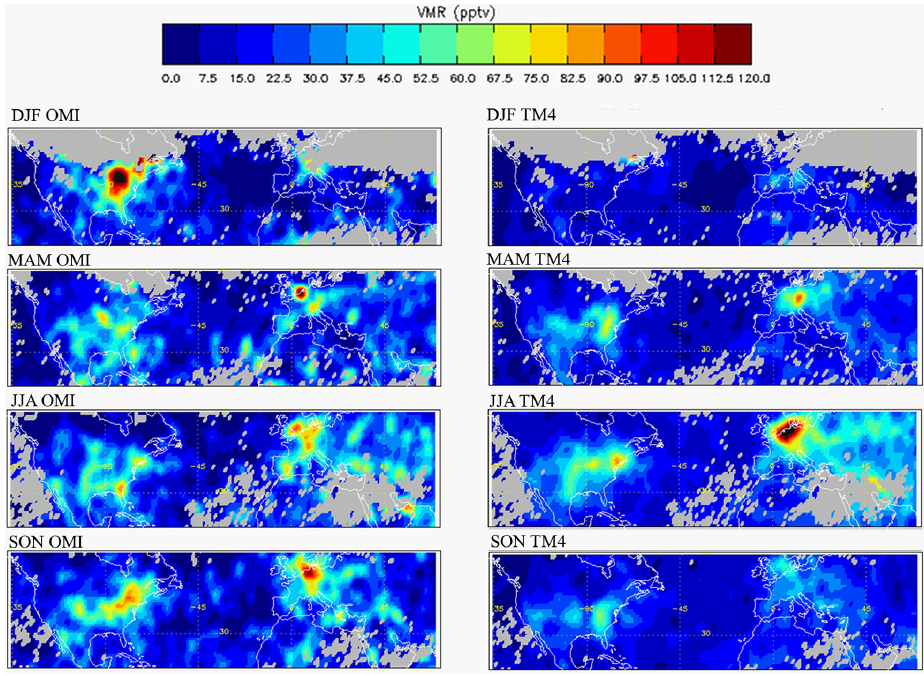
Figure 30. Same as Fig. 29 but at